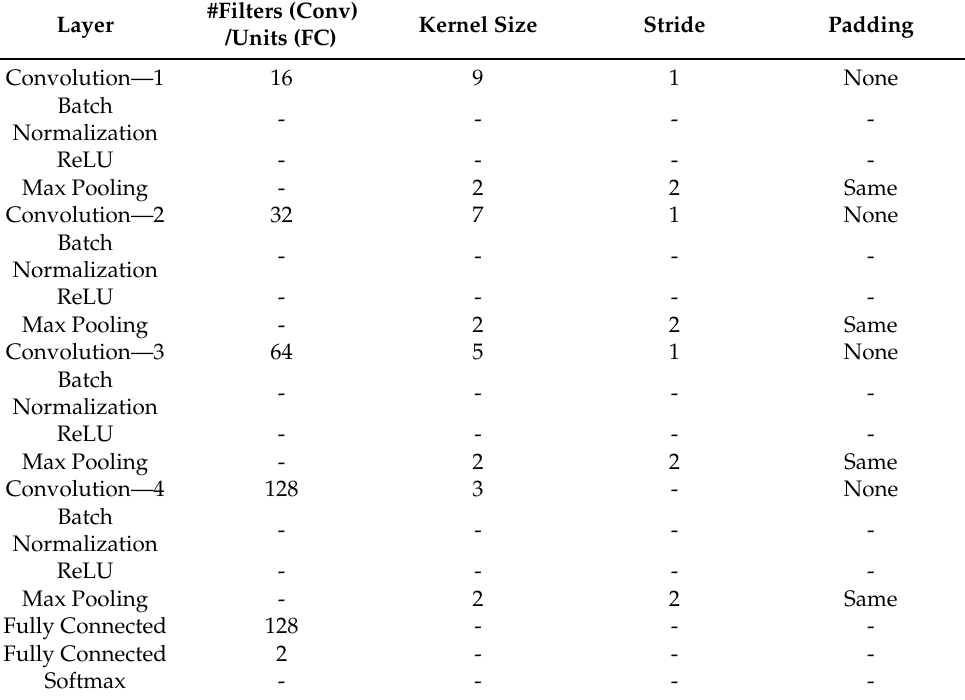
Table 1. Layer-by-layer description for the developed model. As the model deepened, the number of filter increased (16-32-64-128) and the kernel size diminished (9-7-5-3). Max pooling had a stride and kernel size of 2 across the network. The numbers of units in the fully connected layers were 128 and 2.